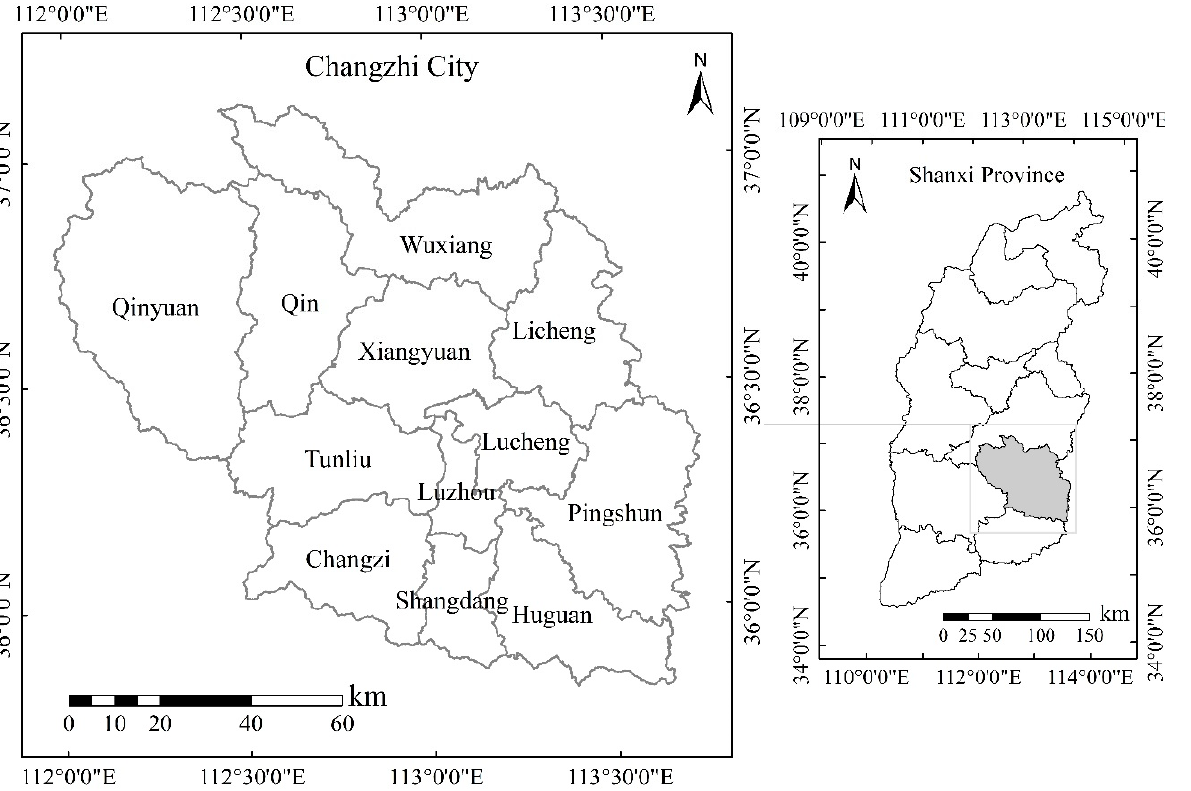
Figure 2. Study site location of Changzhi city in Shanxi, China.